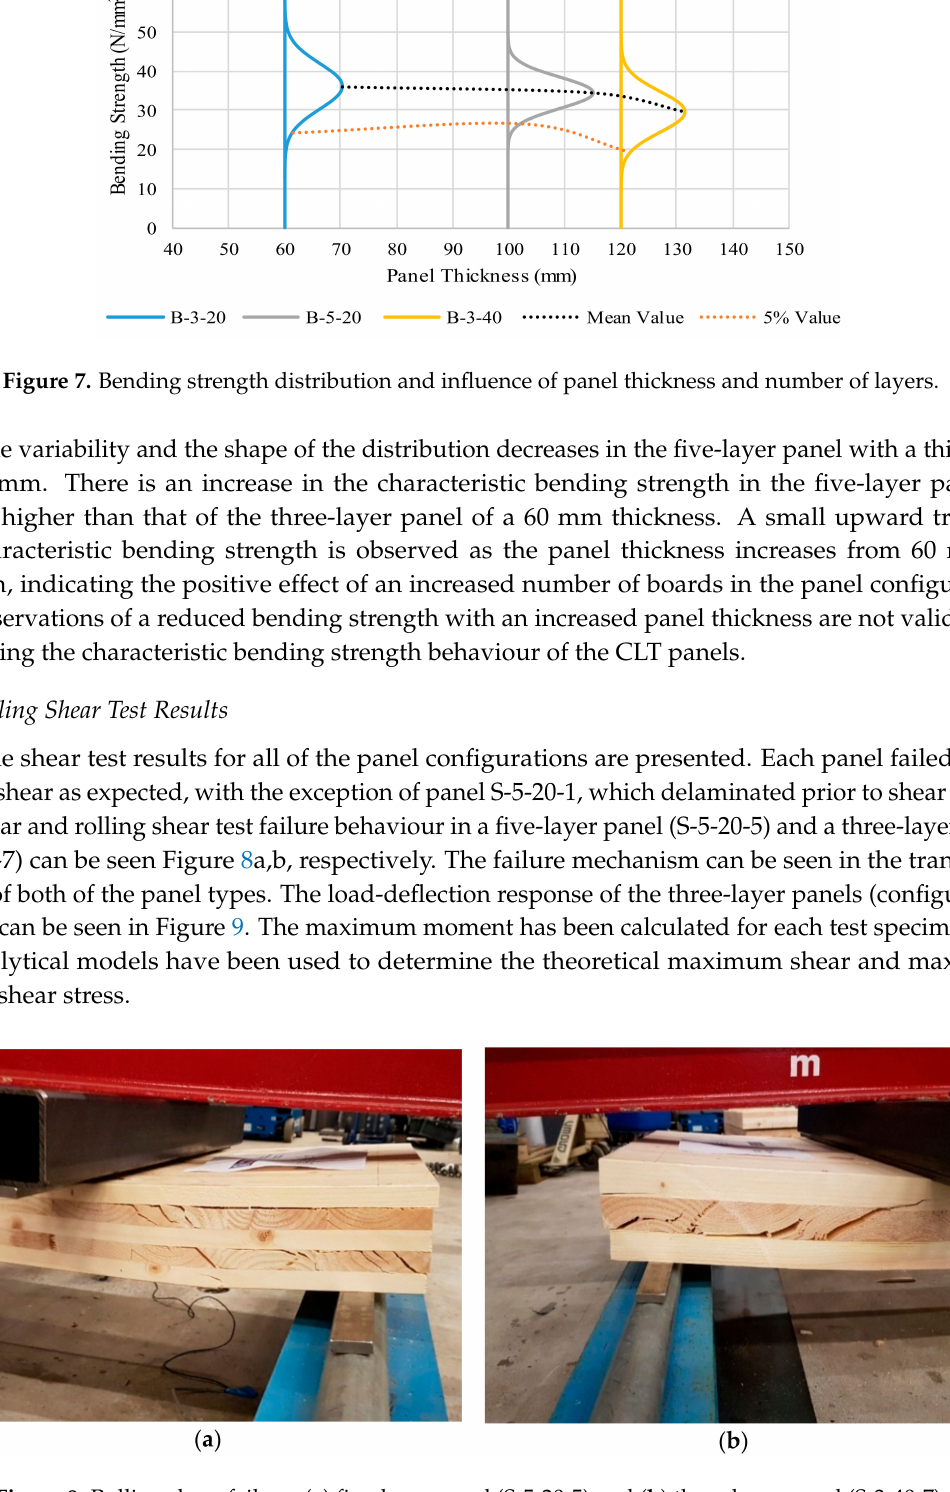
Figure 8. Rolling shear failure: ( a ) five-layer panel (S-5-20-5) and ( b ) three-layer panel